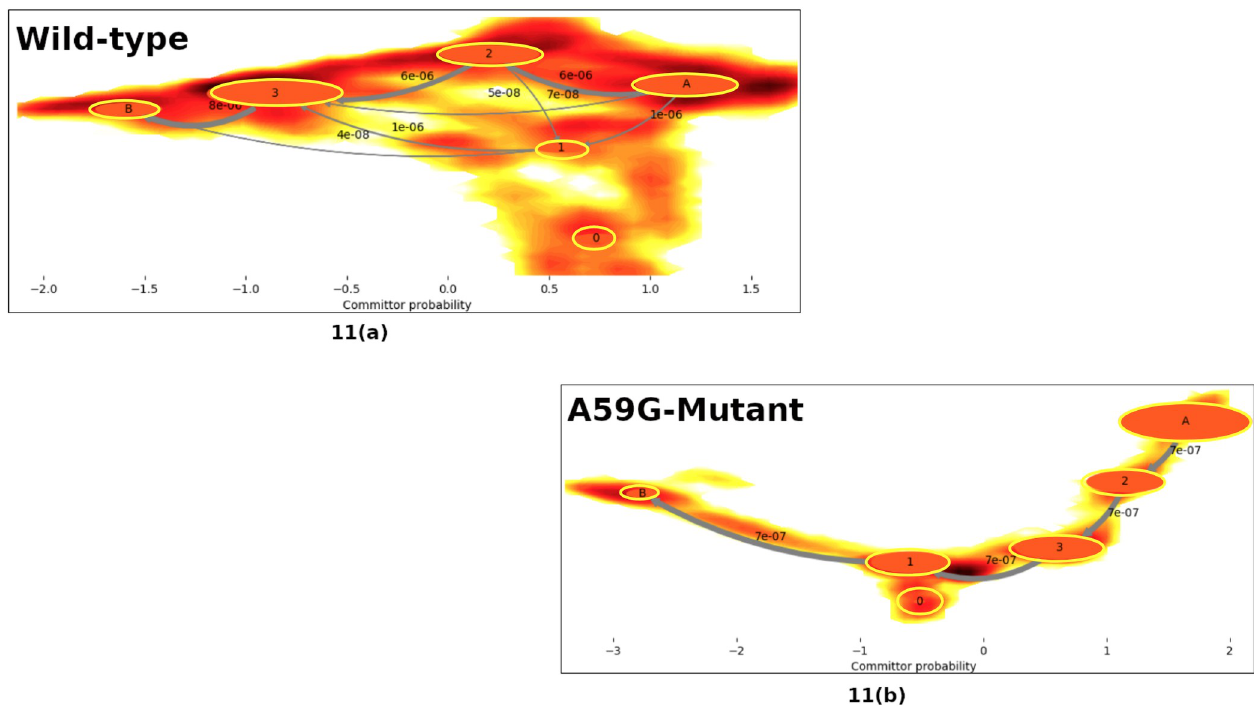
Fig 11. The 2D-plot demonstrating the probable pathways for the wild-type and mutant simulations, calculated using PyEMMA. The most probable pathway is denoted by a bold gray arrow (rightmost to left most cluster). The committor probability of each state transition is written along the respective arrow.